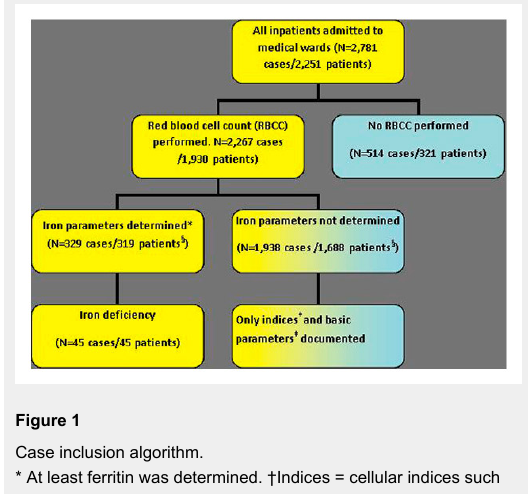
Case inclusion algorithm. * At least ferritin was determined. †Indices = cellular indices such as haemoglobin, mean corpuscular volume (MCV) or the mean cellular haemoglobin concentration (MCHC) ‡ Basic parameters: age, gender, main diagnosis, results of red blood cell count (RBCC) § Number of patients with and without iron parameters do not add up to 1930, because 74 patients had in some cases iron parameters determined and in others